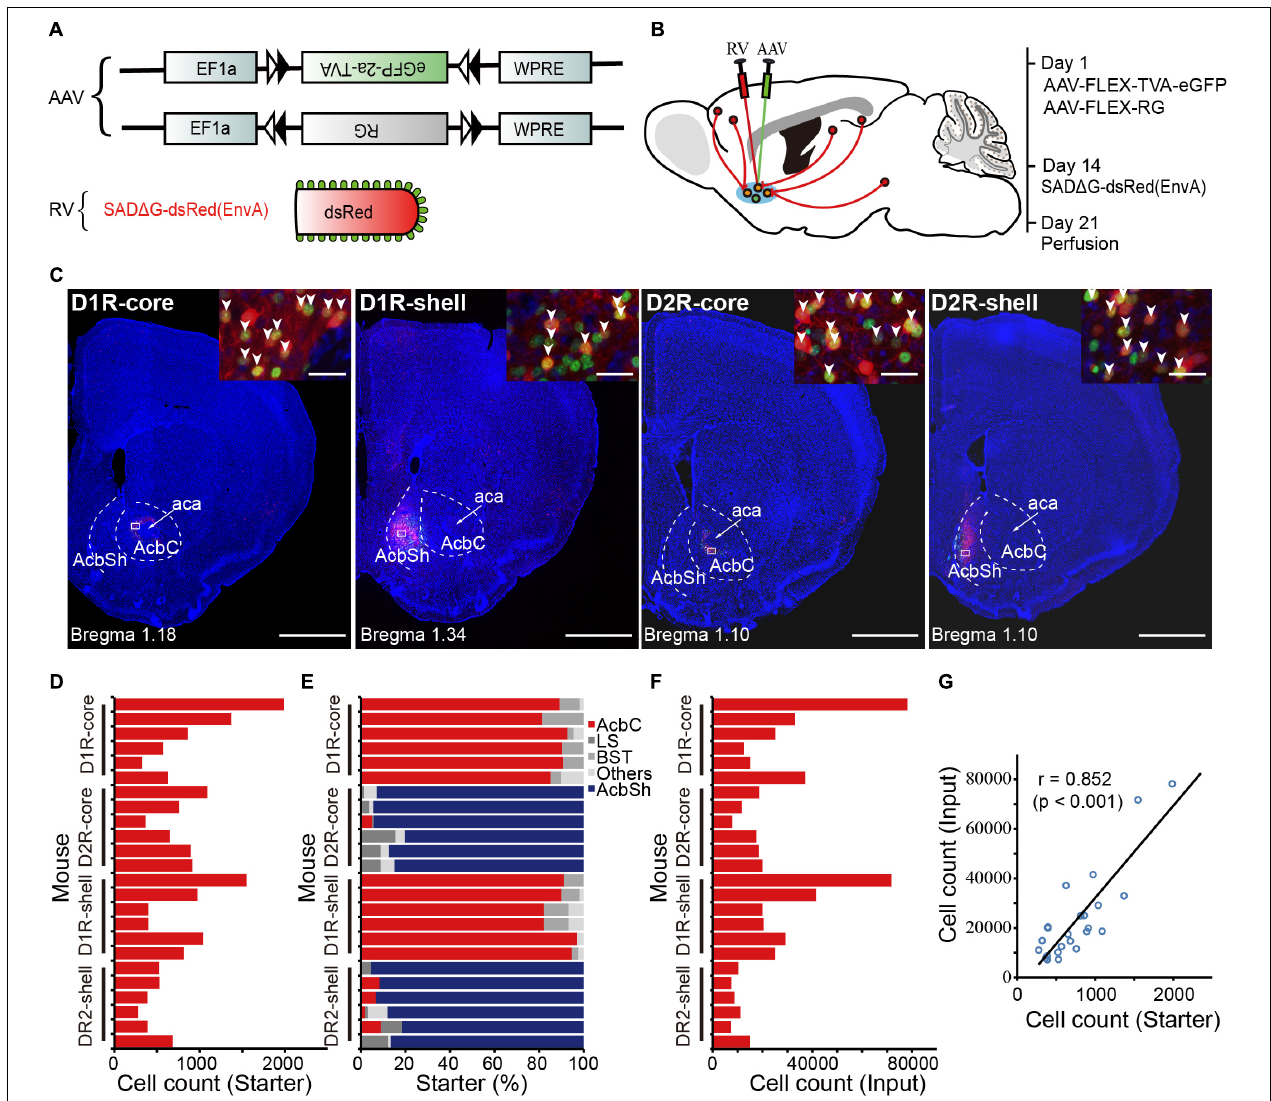
FIGURE 1 | Experimental strategy for identification of monosynaptic inputs to D1R- and D2R-MSNs in different NAc subregions. (A) Recombinant AAV strains and RV. (B) Experimental design. (C) Representative coronal brain sections near the injection sites. Blue indicates cell nuclear staining with DAPI. Scale bar, 1000 µ m. Inset, enlarged view of the area in white the box showing starter cells (yellow, expressing both eGFP and dsRed, indicated by white arrowheads). Scale bar, 30 µ m. AcbC, nucleus accumbens, core (NAc core); aca, anterior commissure, anterior part; AcbSh, nucleus accumbens, shell (NAc shell). (D) Numbers of starter neurons in the individual animals. (E) Proportions of labeled starter neurons in injection regions. LS, lateral septal nucleus; BST, bed nucleus of the stria terminalis. (F) Numbers of transsynaptically labeled neurons, i.e., input neurons in the individual animals. (G) A linear relationship was detected between the number of starter and input